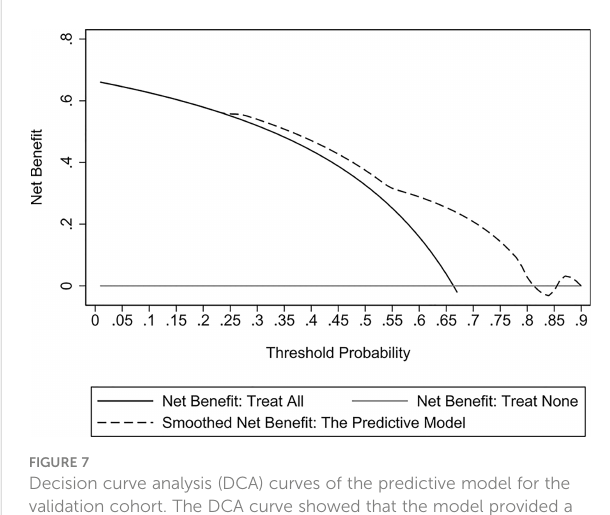
FIGURE 7 Decision curve analysis (DCA) curves of the predictive model for the validation cohort. The DCA curve showed that the model provided a high practical value in clinical practice when the predicted probability was > 0.75 in the validation